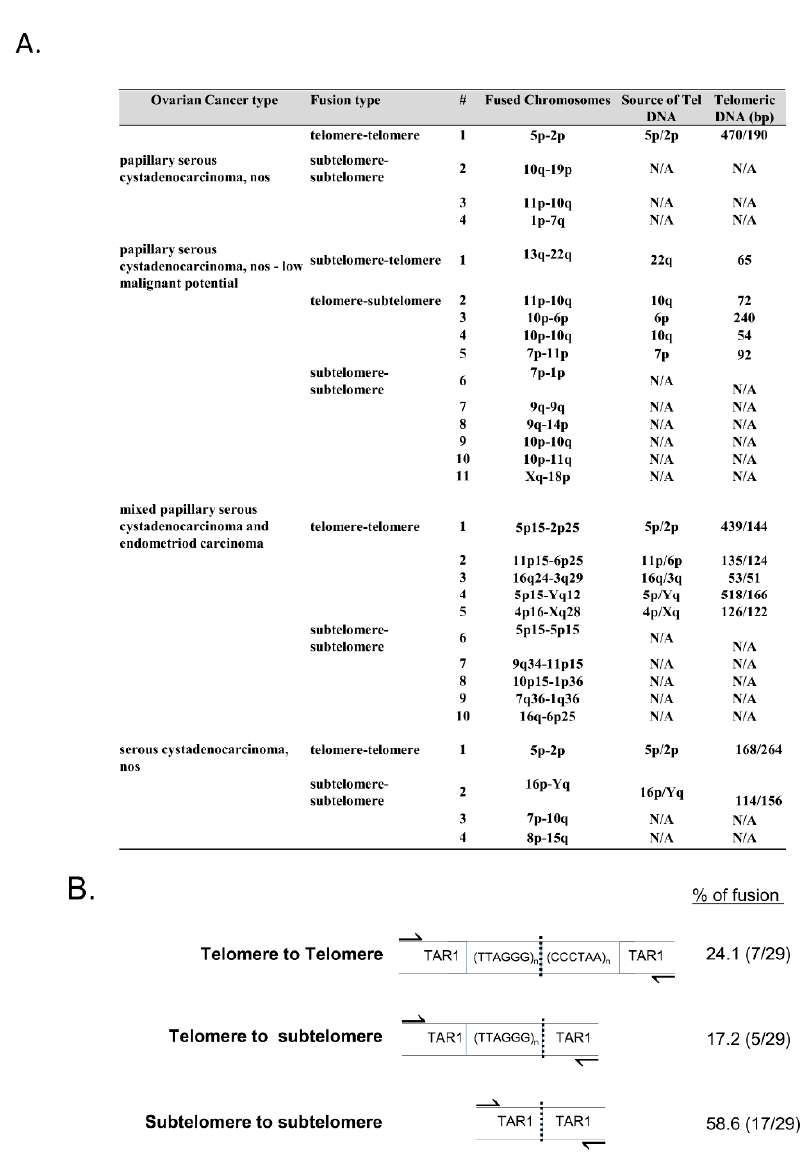
Figure 2. Telomere length and fusion analysis. ( A ) Each tumor tissue sample was evaluated for telomere length using qPCR. Each sample’s fusion type, categorization of fused chromosomes, and telomeric DNA (bp) length is shown. ( B ) Breakdown of the types of telomere fusion found in the above samples.